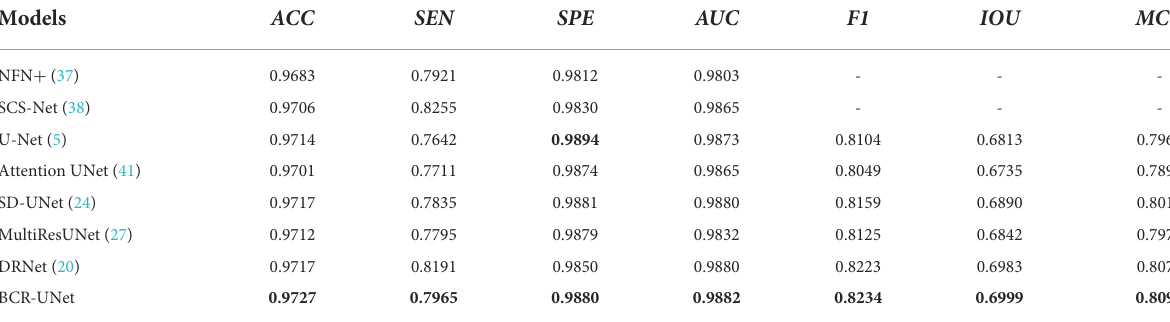
TABLE 8 Results of BCR-UNet and other methods on IOSTAR dataset.